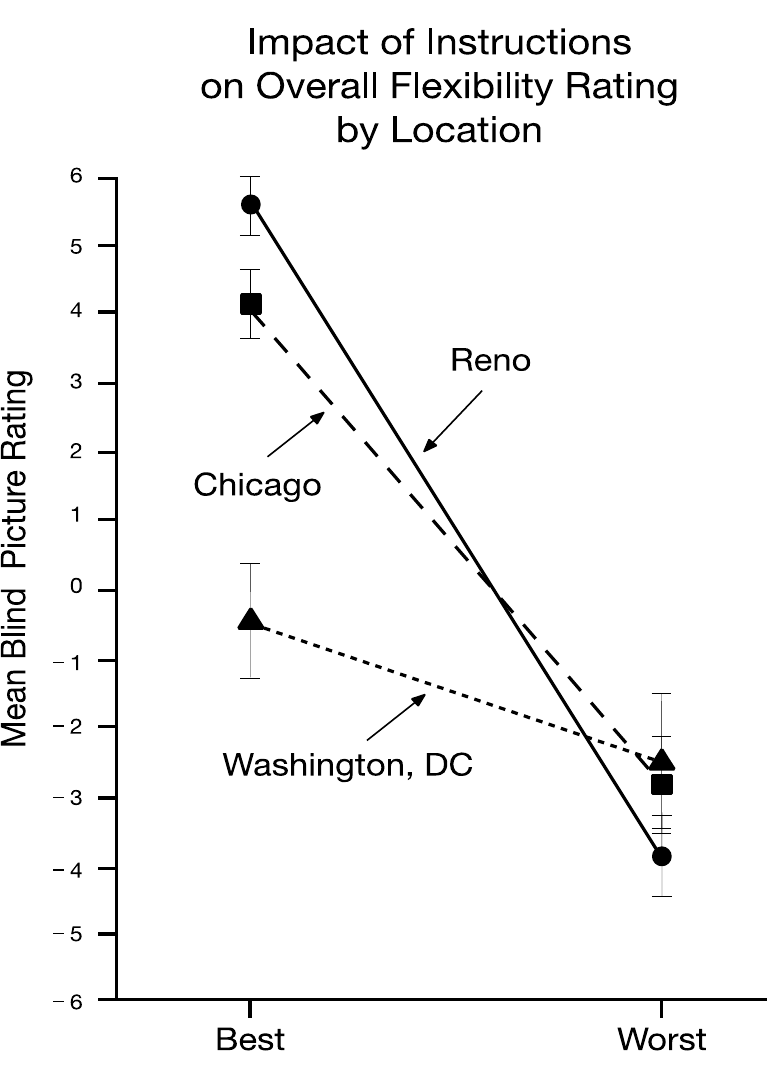
Figure 2. Mean composite scores for the best and worst poses in Reno, Chicago, and Washington, DC.